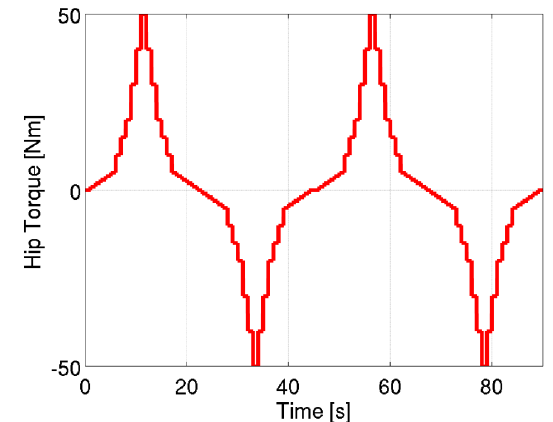
Figure 9. Hip torque steps performed during the